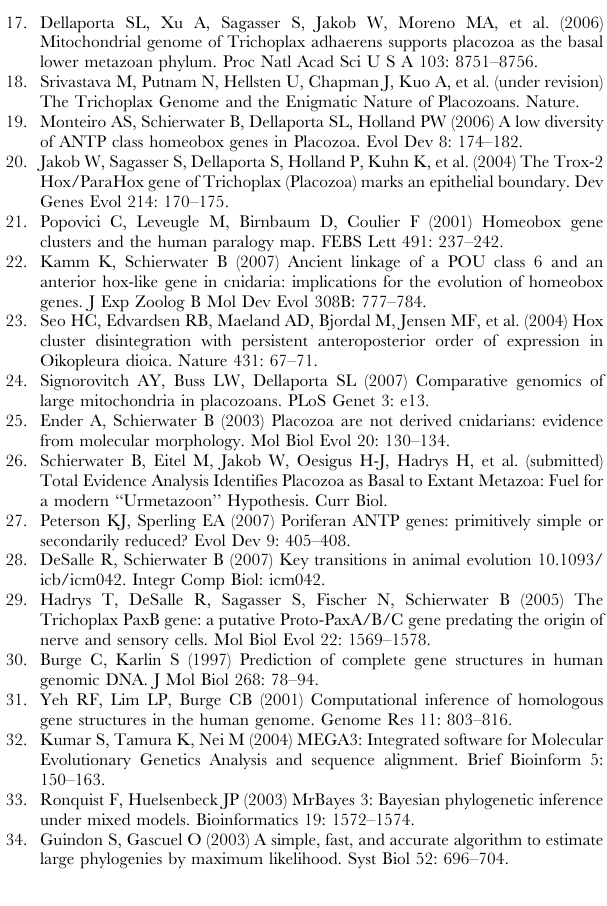
Table S1 Sequences of the Trichoplax homeodomains/homeo- boxes as well as other conserved motifs and genomic scaffold